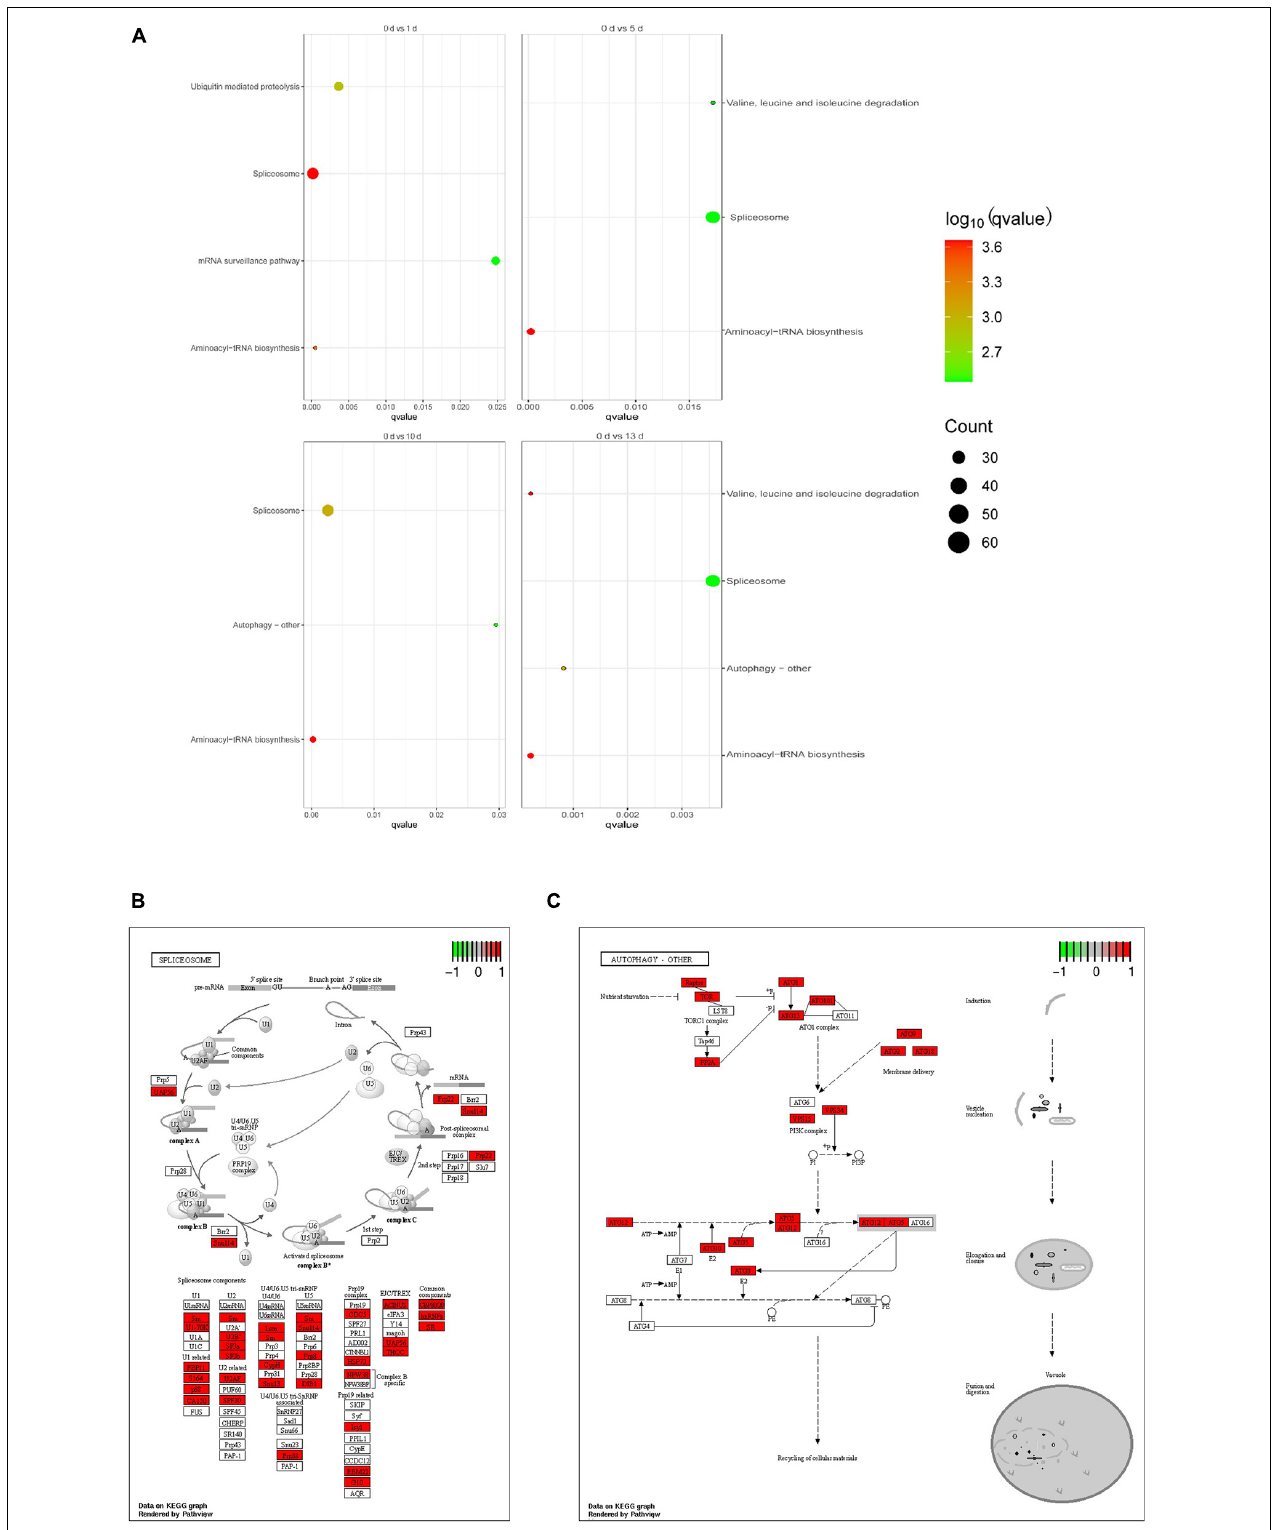
FIGURE 5 | Function enrichment analysis of DAS events of date palm in response to high salinity. (A) KEGG pathway analysis for the DAS events of date palm in response to high salinity. (B) The pathview of enrichment pathway “Spliceosome” was identified in (A) . (C) The pathview of enrichment pathway “autophagy-other” was identified in (A)